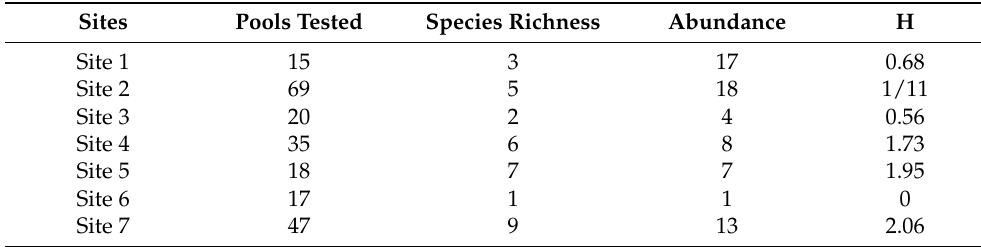
Table 3. Species diversity indices of the bacterial communities in ticks by sites. Pools made up of larvae were excluded. H refers to Shannon Diversity Index, and NA to not available.